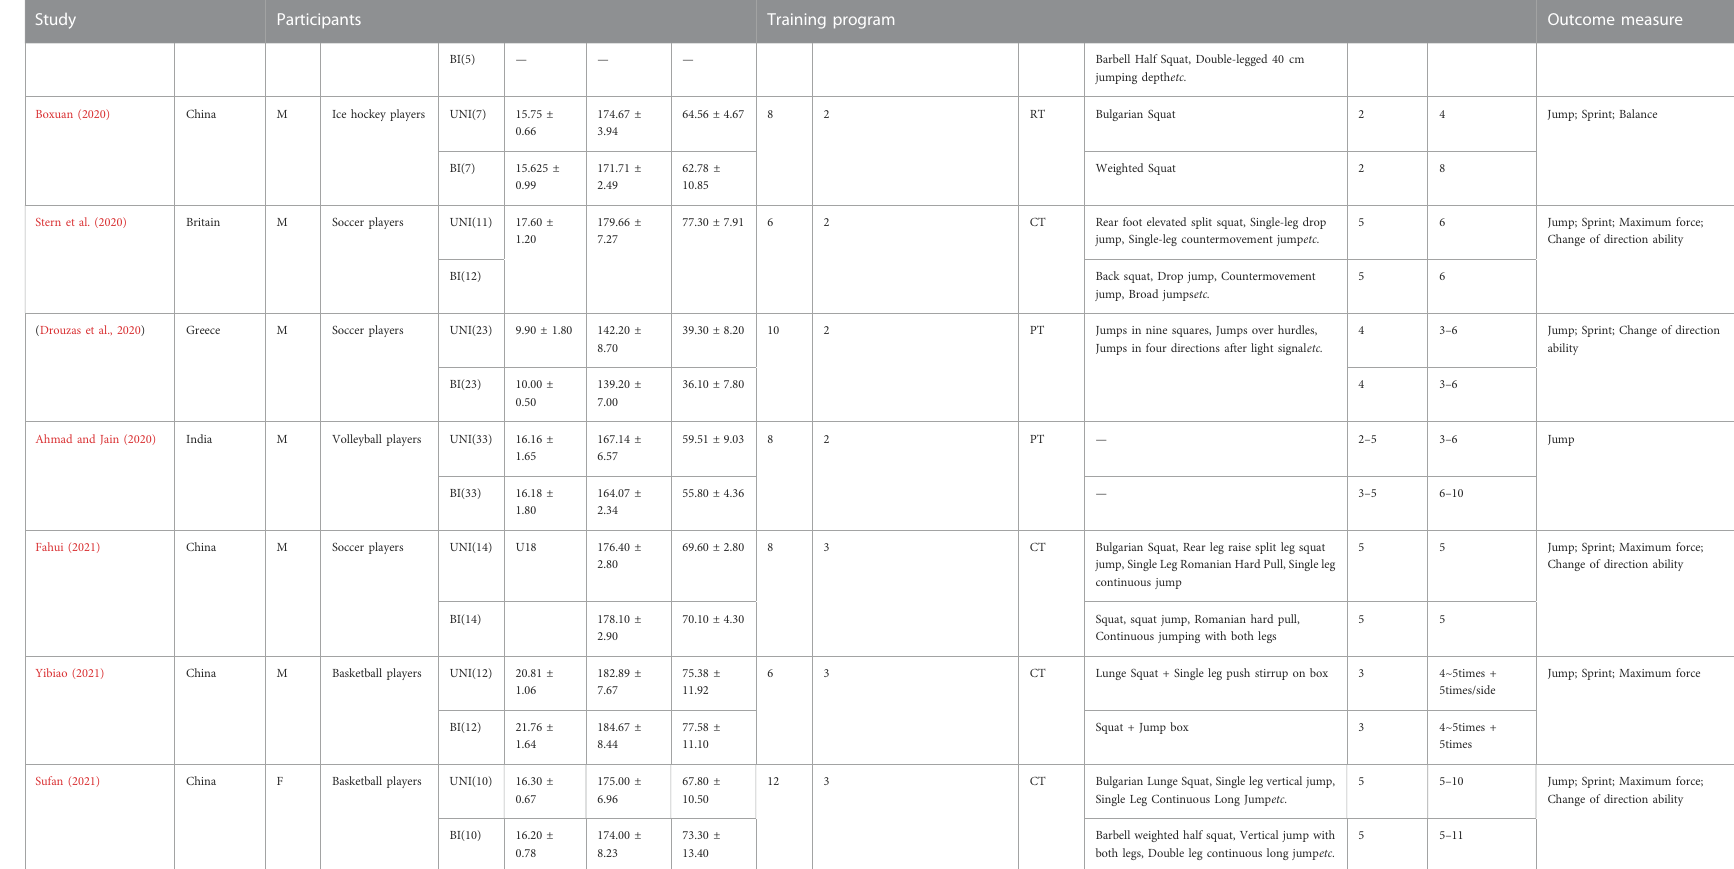
TABLE 2 ( Continued ) List of basic characteristics of the included literature Abbreviations: M = male; F = female; RT = Resistance training; PT = Plyometric training; CT = complex training; EOT = Eccentric-overload training.